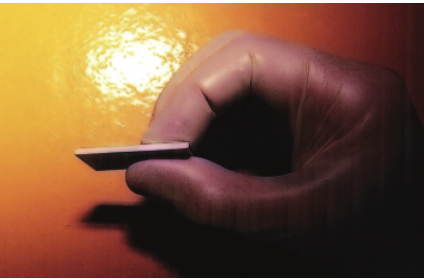
Figure 11: Side view of the fuel rectangle.